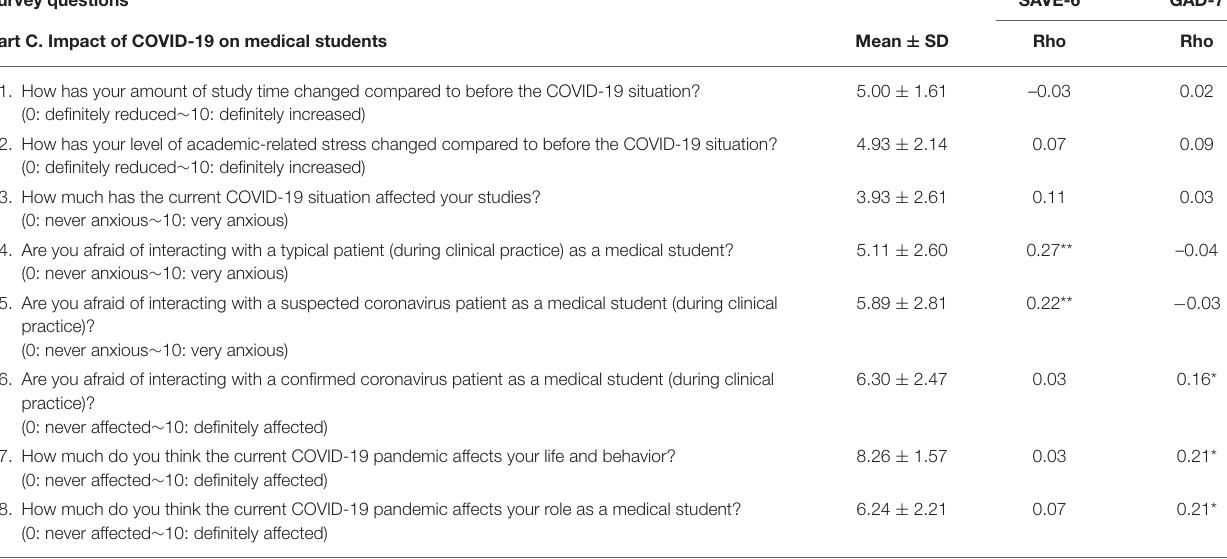
TABLE 3 | Correlation coefficients of students’ responses to the survey questions with anxiety rating scales